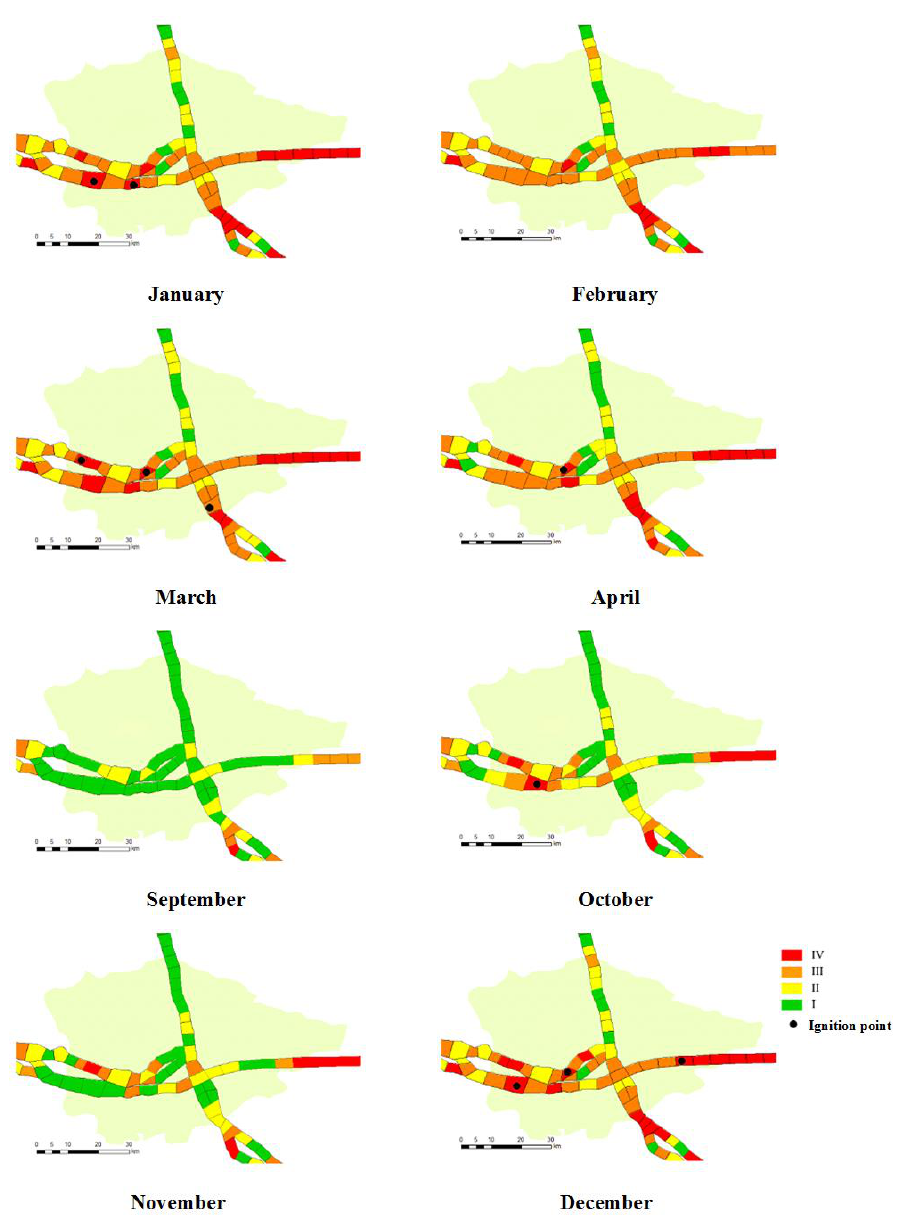
Figure 5. A comparison between the predictive results provided by the developed model and the actual wildfire accidents that occurred in Xianning (29.50° N, 114.19° E) in 2015 . In the second experiment, a total of 30 historical line tripping events, which were caused by wildfires in high-voltage PLCs and recoded from 2008 to 2014 in the whole Hubei Province, were used. Here, all historical line tripping data were also purchased from the State Grid Hubei Electric Power Co. Ltd. (www.hb.sgcc.com.cn). Furthermore, eighty percent of the historical tripping data were randomly selected for training, and the remaining data were used for inner validation. According to the above historical wildfire data, the obtained logistic regression model is shown as follows: